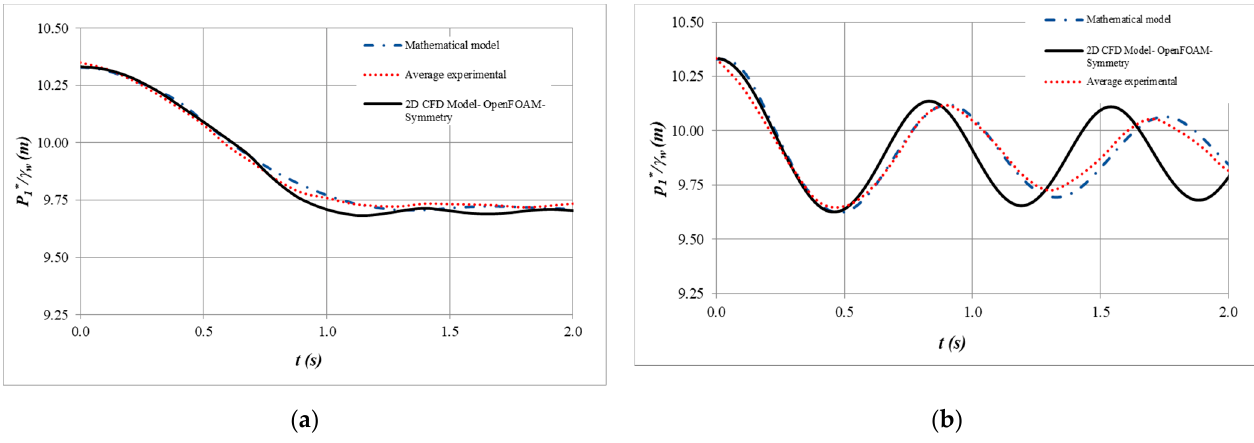
Figure 10. Comparison of pressure and speed values for the different models: ( a ) air pocket pressure values for case A1; ( b ) air pocket pressure values for case B5.